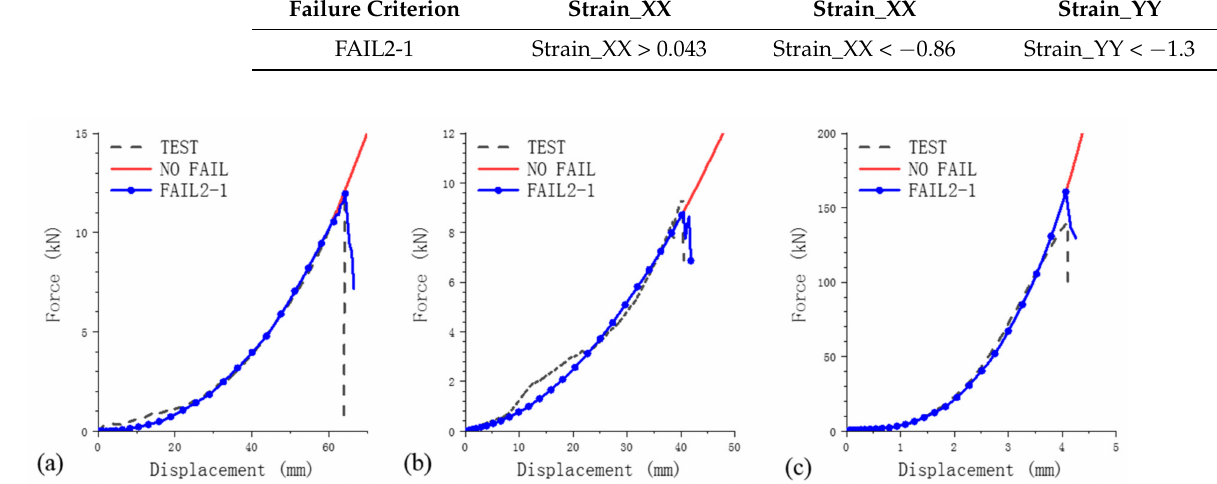
Figure 12. Simulation results with failure criterion considering tension strain and compression strain: ( a ) X direction; ( b ) Y direction; ( c ) Z direction.